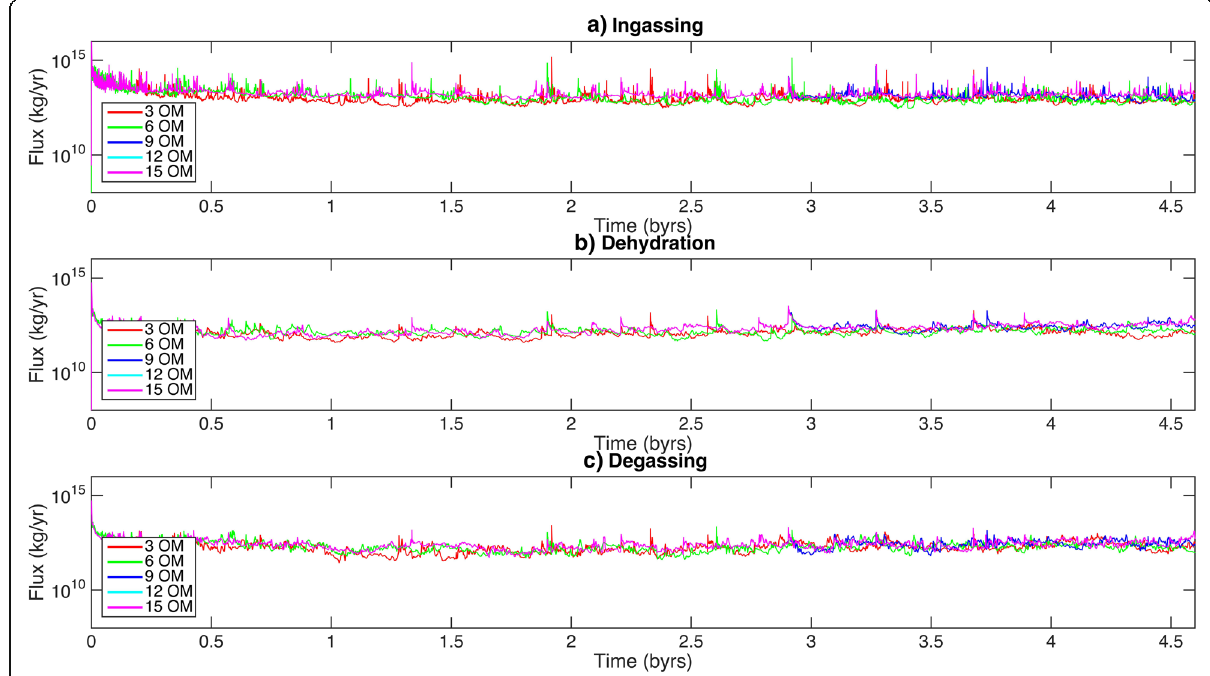
Fig. 7 Water flux diagnostics as a function of time varying with the total amount of water in the entire system as a function of time. a Ingassing. b Dehydration. c